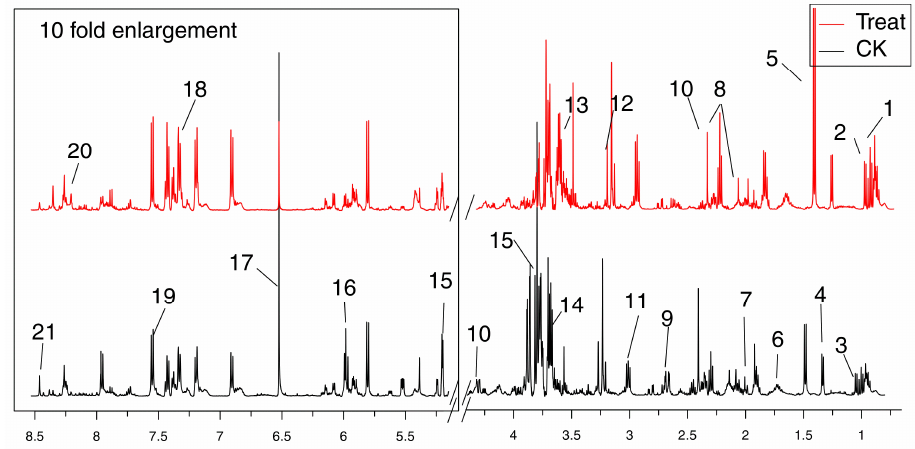
Figure 3. Typical 500 MHz 1 H-NMR spectra obtained from the treat and CK groups. Metabolites were assigned: 1. Leucine; 2. Isoleucine; 3. Valine; 4. 2-Hydroxyisobutyrate; 5. Alanine; 6. Lysine;